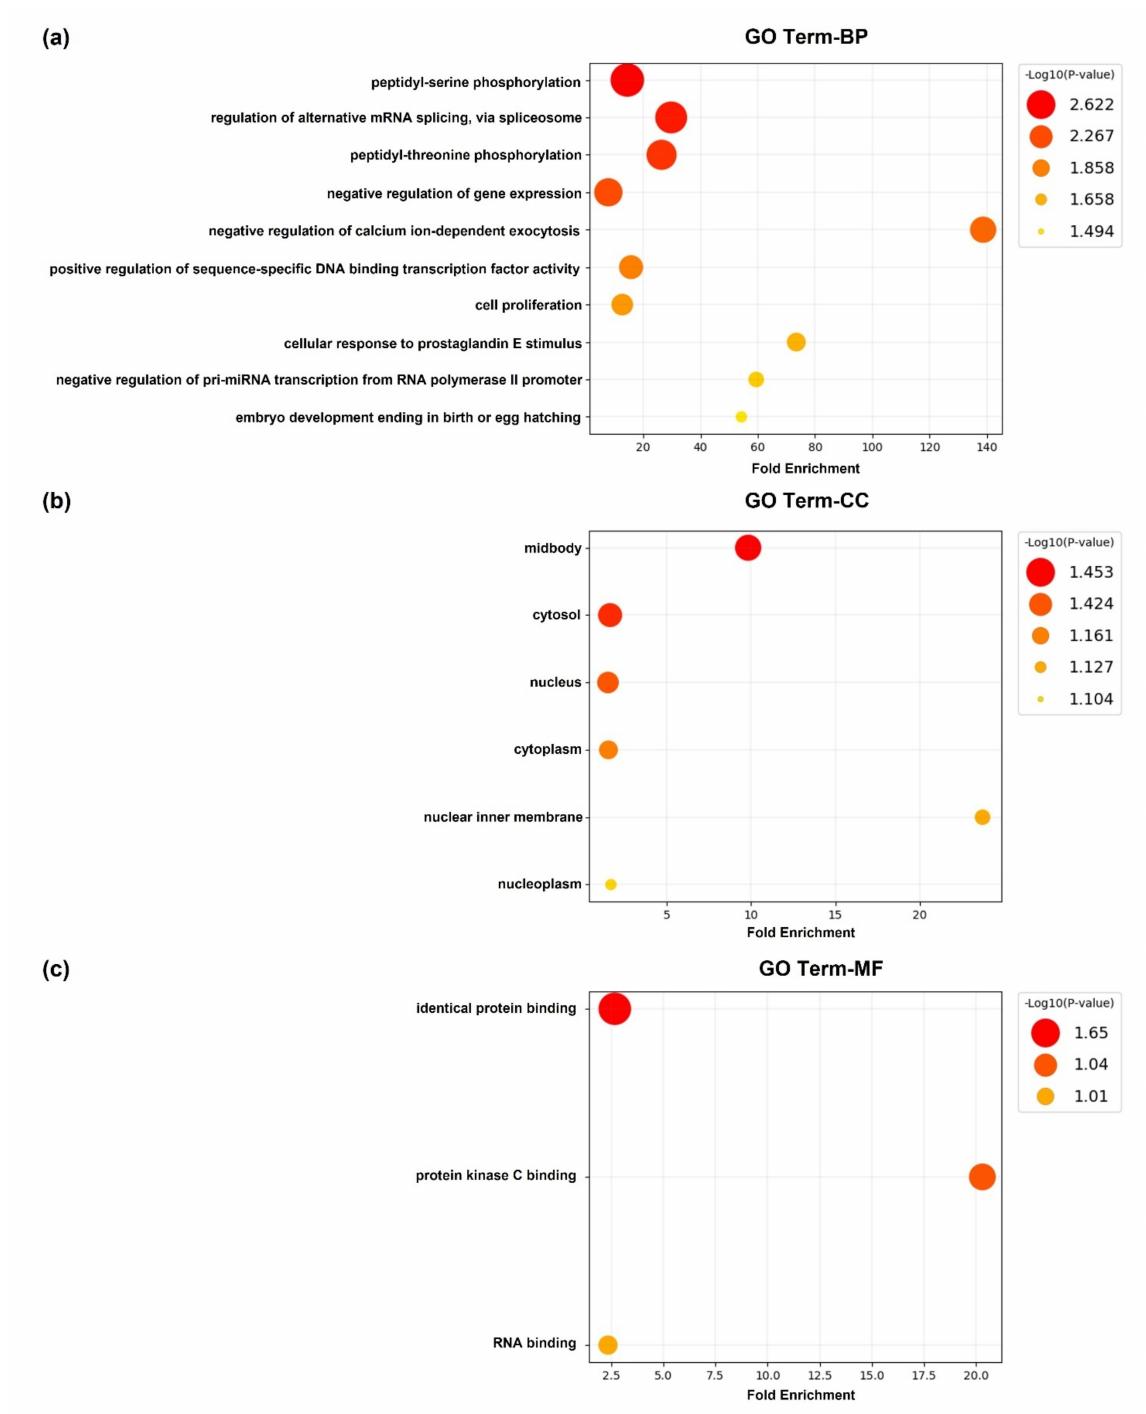
Figure 4. The gene ontology (GO) annotation analyses of the predicted target genes of the DE miRNAs. The top 10 most remarkably affected GO terms are listed along the y -axes. The x -axes denote fold enrichment. p < 0.05 was considered to indicate significant enrichment. The color and size of each dot denote –log10 ( p -value). ( a ) The enrichment according to the biological process for the target genes of downregulated DE miRNAs, ( b ) the enrichment according to the cellular component for the target genes of downregulated DE miRNAs, ( c ) the enrichment according to the molecular function for the target genes of downregulated DE